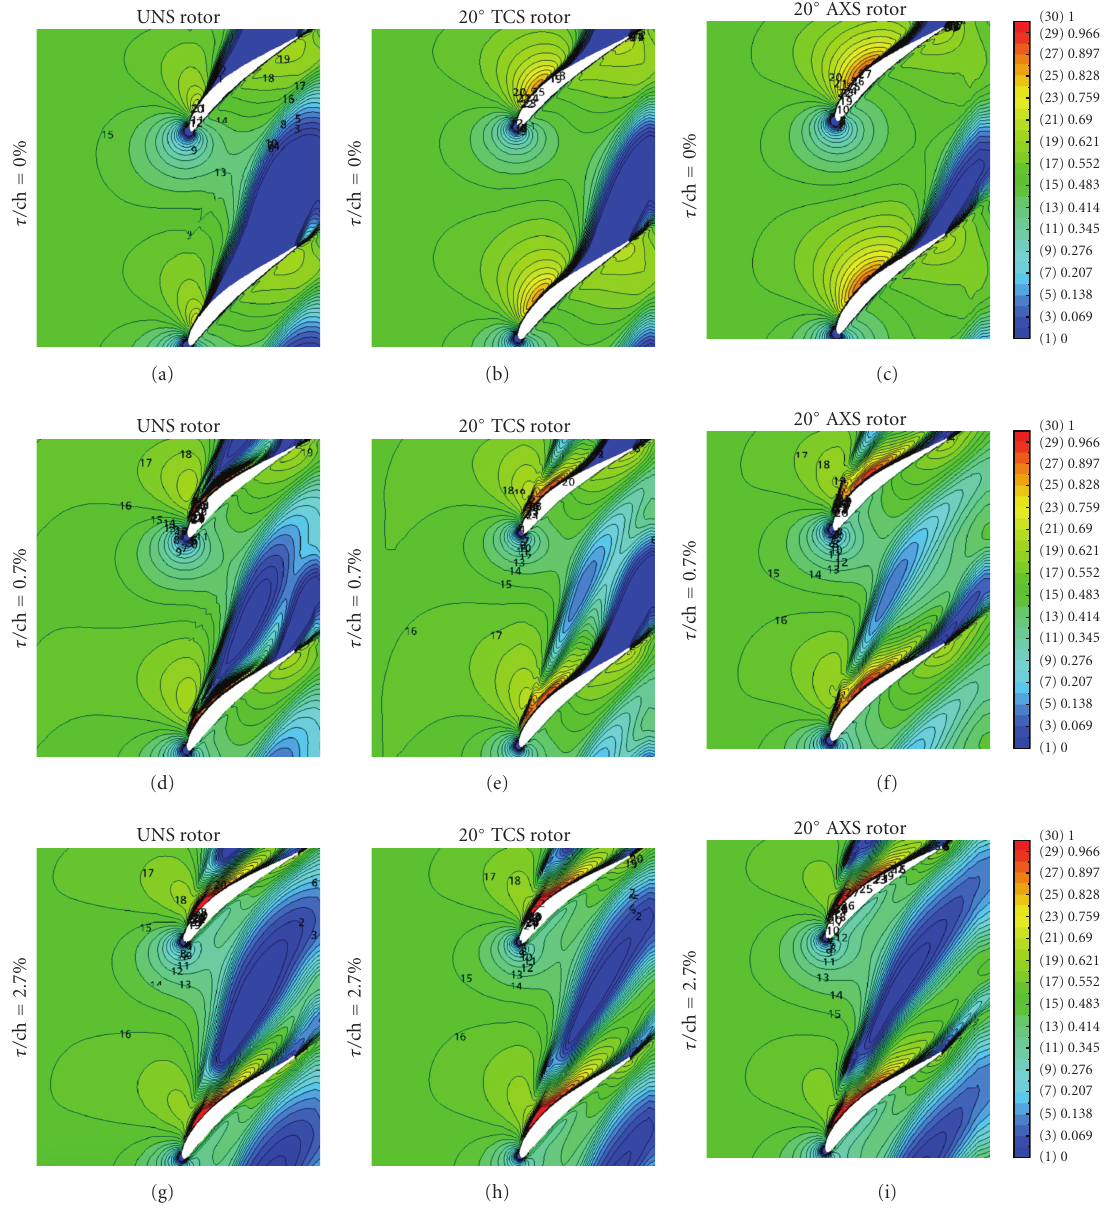
Figure 5: Axial velocity coe ffi cient contours on blade-to-blade planes 1.5 mm from the rotor tip at φ = 0.50.